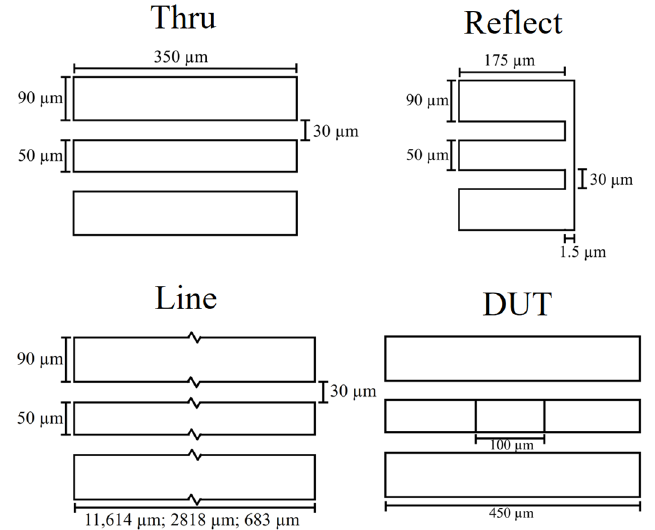
Figure 1. Calibration structures and dimensions used in the implementation of the TRL calibration algorithm.